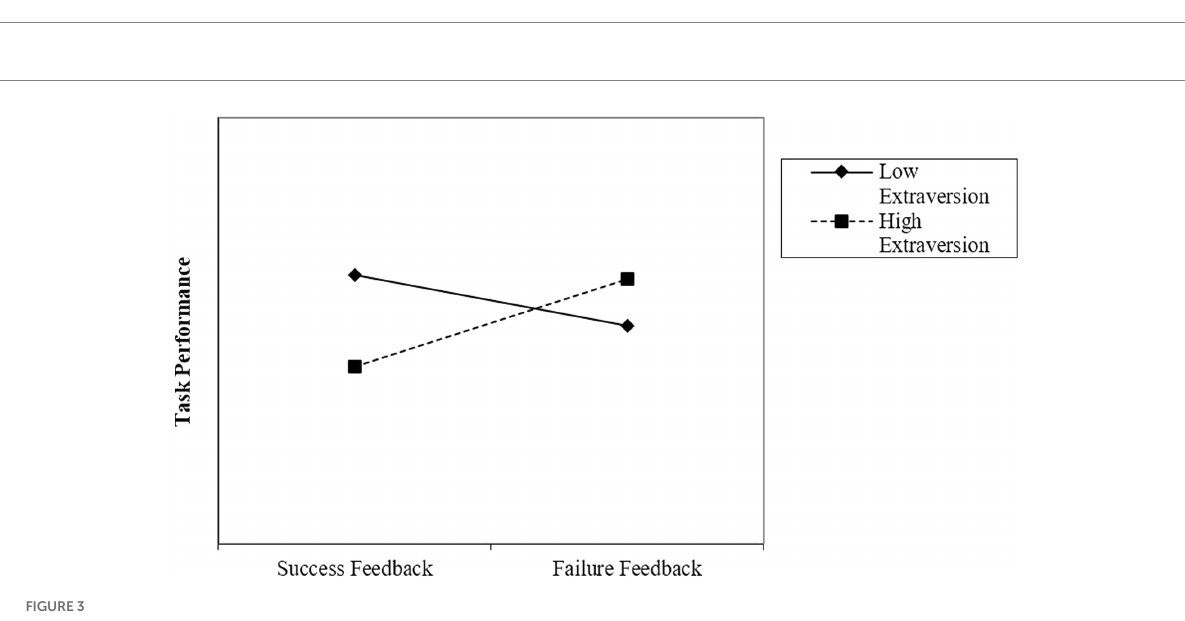
FIGURE 2 The moderating effect of conscientiousness.